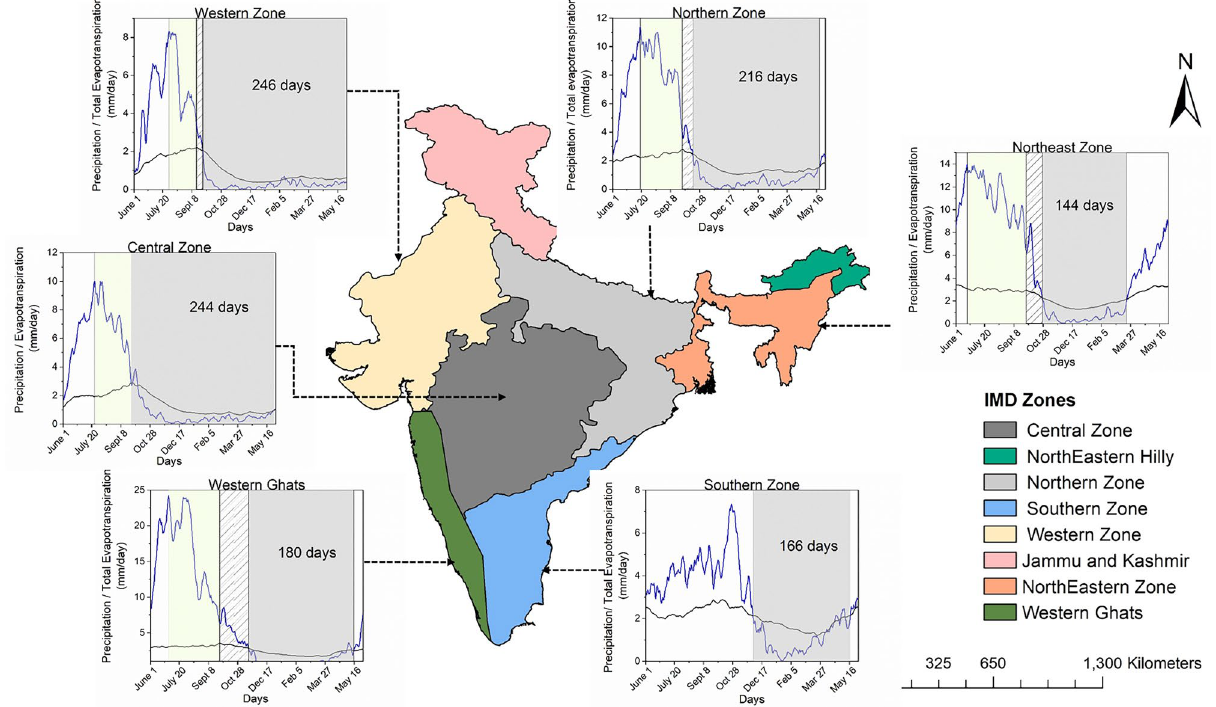
Figure 2. Spatial variability of capacitor days across different homogeneous meteorological subdivisions over India (climatology for the period 2001 to 2015). The shaded yellow, hatched and grey regions correspond to the delayed response period, pre-capacitor period and capacitor period, respectively. The plots are prepared in Origin